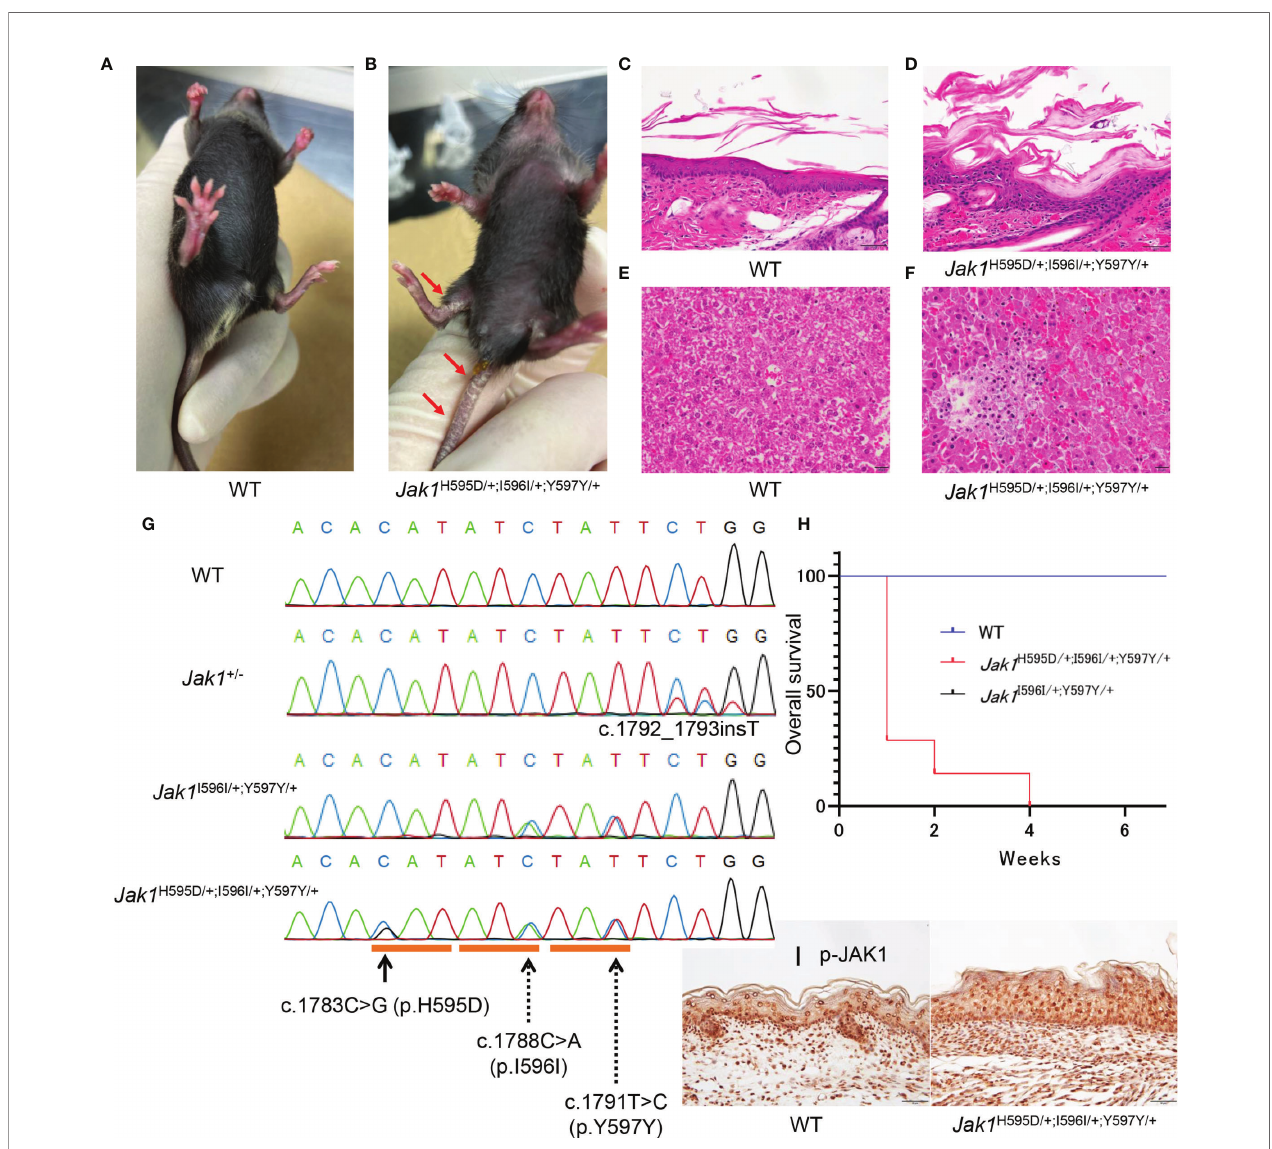
FIGURE 2 | Phenotypic features in Jak1 H595D/+;I596I/+;Y597Y/+ mice. (A, B) The gross appearance of WT (A) and Jak1 H595D/+;I596I/+;Y597Y/+ (B) at 4 weeks of age. The Jak1 H595D/+;I596I/+;Y597Y/+ mouse shows scaling on the ears, the extremities, and the tail. (C, D) Hematoxylin and eosin staining of the skin reveals acanthosis, hyperkeratosis and parakeratosis in the Jak1 H595D/+;I596I/+;Y597Y/+ mouse (D) , but not in the WT mouse (C) . Scale bars = 50 µm. (n = 3) (E, F) Histology of liver sections from the Jak1 H595D/+;I596I/+;Y597Y/+ mice (F) and the WT mice (E) stained with hematoxylin and eosin. Scale bars = 50 m m. (n = 3) (G) Sequence data of Jak1 around the mutations in the Jak1 H595D/+;I596I/+;Y597Y/+ , Jak1 I596I/+;Y597Y/+ and Jak1 +/- mice. The black line indicates c.1783C>G (H595D). The dotted lines indicate two synonymous changes: c.1788C>A (I596I) and c.1791T>C (Y597Y). (H) A graph of the overall survival rate ( Jak1 H595D/+;I596I/+;Y597Y/+ : n = 7, WT: n = 10, Jak1 I596I/+;Y597Y/+ : n=10). Log-rank test, WT vs Jak1 H595D/+;I596I/+;Y597Y/+ mice: p value < 0.0001, Jak1 I596I/+;Y597Y/+ vs Jak1 H595D/+;I596I/+;Y597Y/+ mice: p value < 0.0001. (I) Immunohistochemical analysis by using the anti-p-JAK1 antibody for the palmar skin of the Jak1 H595D/+;I596I/+;Y597Y/+ mice and the WT mice. Scale bars = 50 µm. (n =